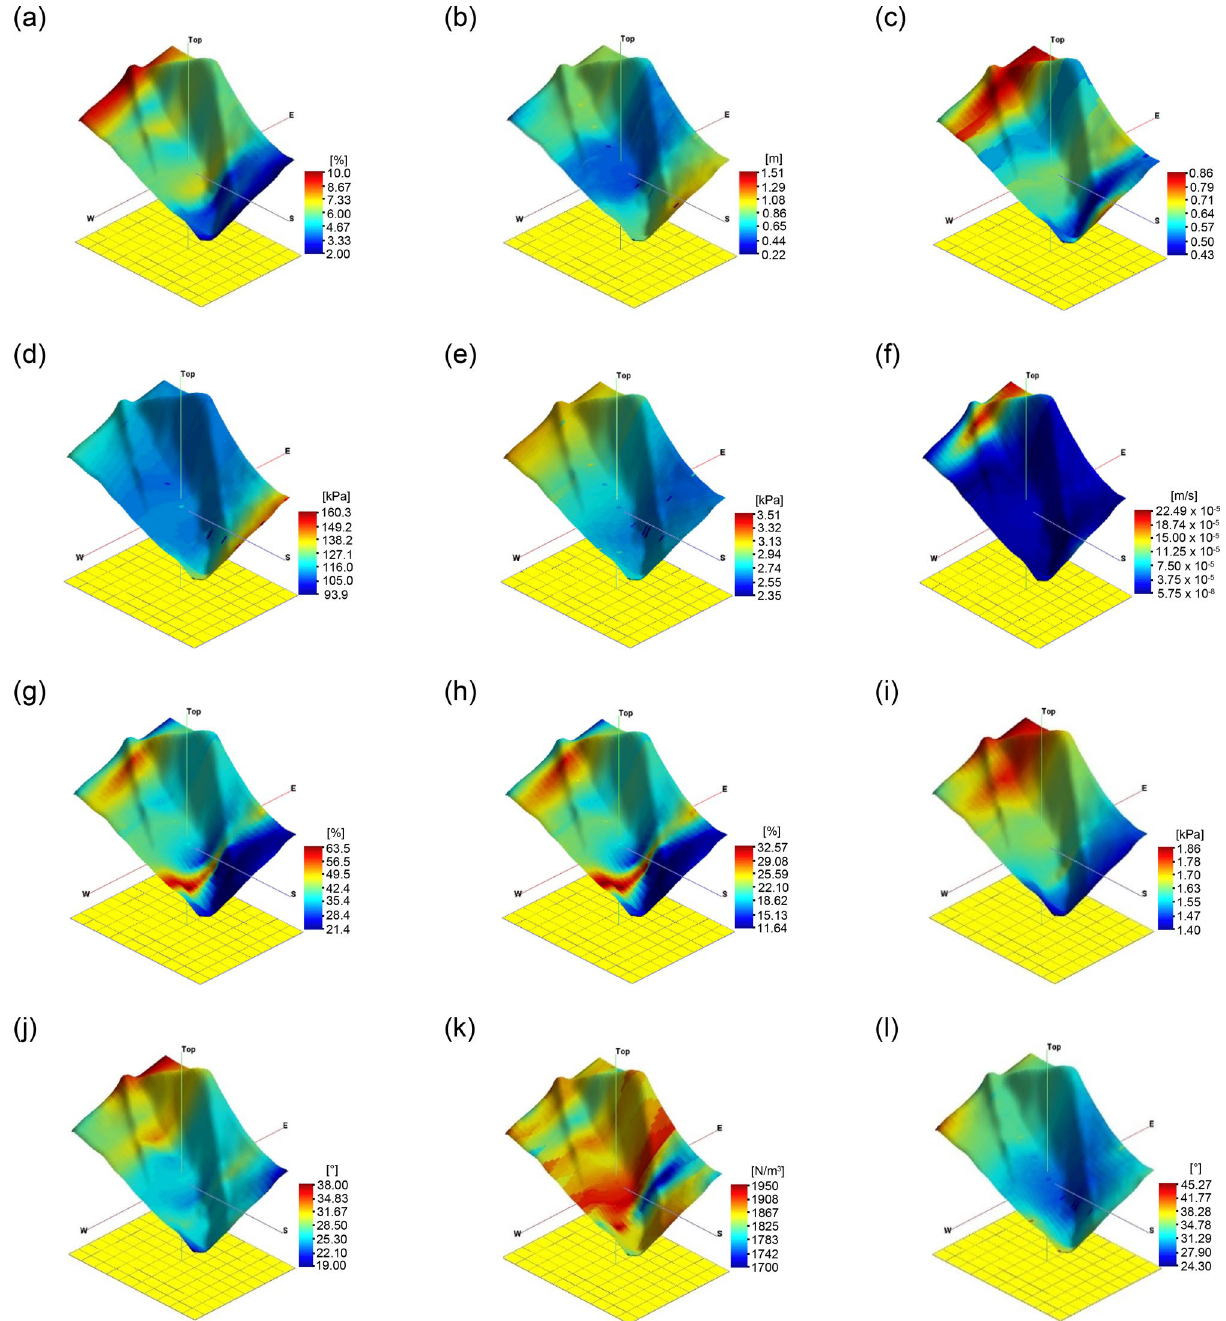
Figure 9. Kriging results of input variables: ( a ) fine content; ( b ) soil thickness; ( c ) porosity; ( d ) elastic modulus; ( e ) shear strength; ( f ) hydraulic conductivity; ( g ) saturation; ( h ) water content; ( i ) soil cohesion; ( j ) slope angle; ( k ) soli density; ( l ) friction angle. The software of SGeMS beta (v.2.5b) was applied to draw this